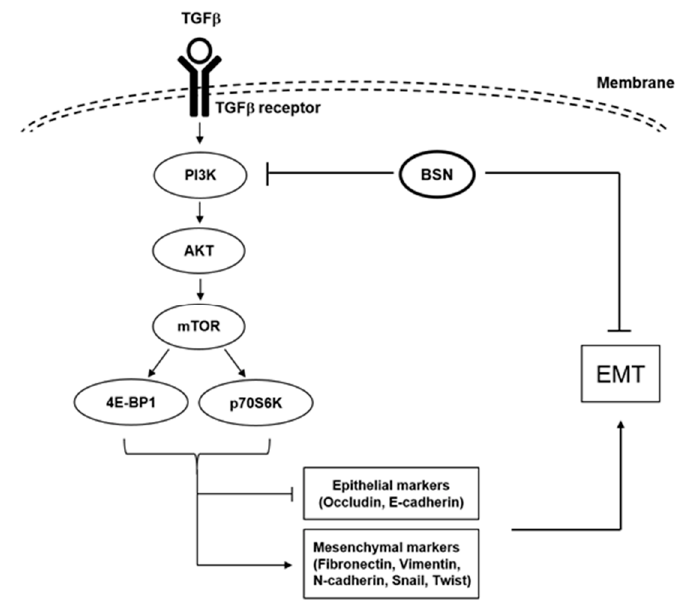
Figure 6. A diagrammatic representation of the possible actions of BSN on PI3K/Akt/mTOR cascade in tumor cells.